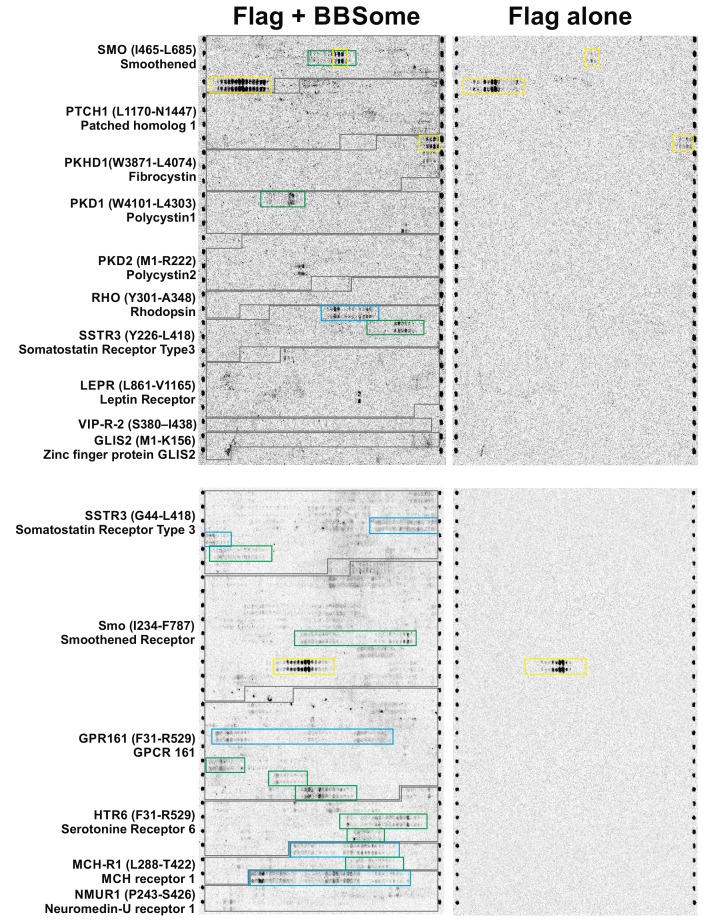
Peptide microarray with core BBSome.15-residue peptide fragments of different potential BBSome-binding proteins were immobilized on a microarray in duplicate and analyzed for their affinity to the core BBSome. The captured BBSome was detected by a fluorescent Flag-antibody (labelled with Dylight800, PepPerPrint, Germany) that was targeted to the Flag-tagged BBS8 subunit. As a control, the microarray was first incubated with Flag-antibody alone and the corresponding fluorescence image was used to identify any direct interactions of the antibody with immobilized peptides (yellow boxes indicate these potentially false-positive signals). Relevant BBSome interactions with the third intracellular loops of GPCRs are marked as blue boxes, while interactions with the C-terminal cytoplasmic domains are marked with green boxes.